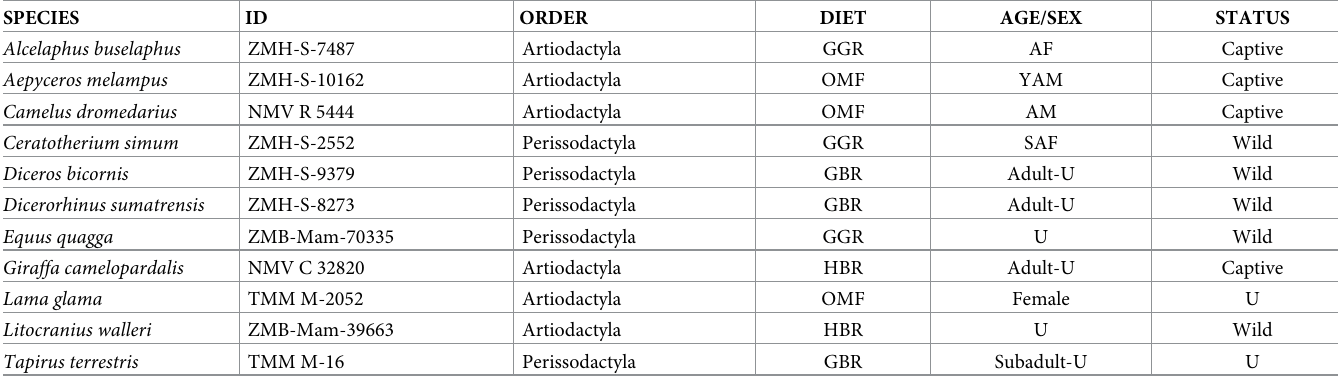
Table 1. List of ungulate species